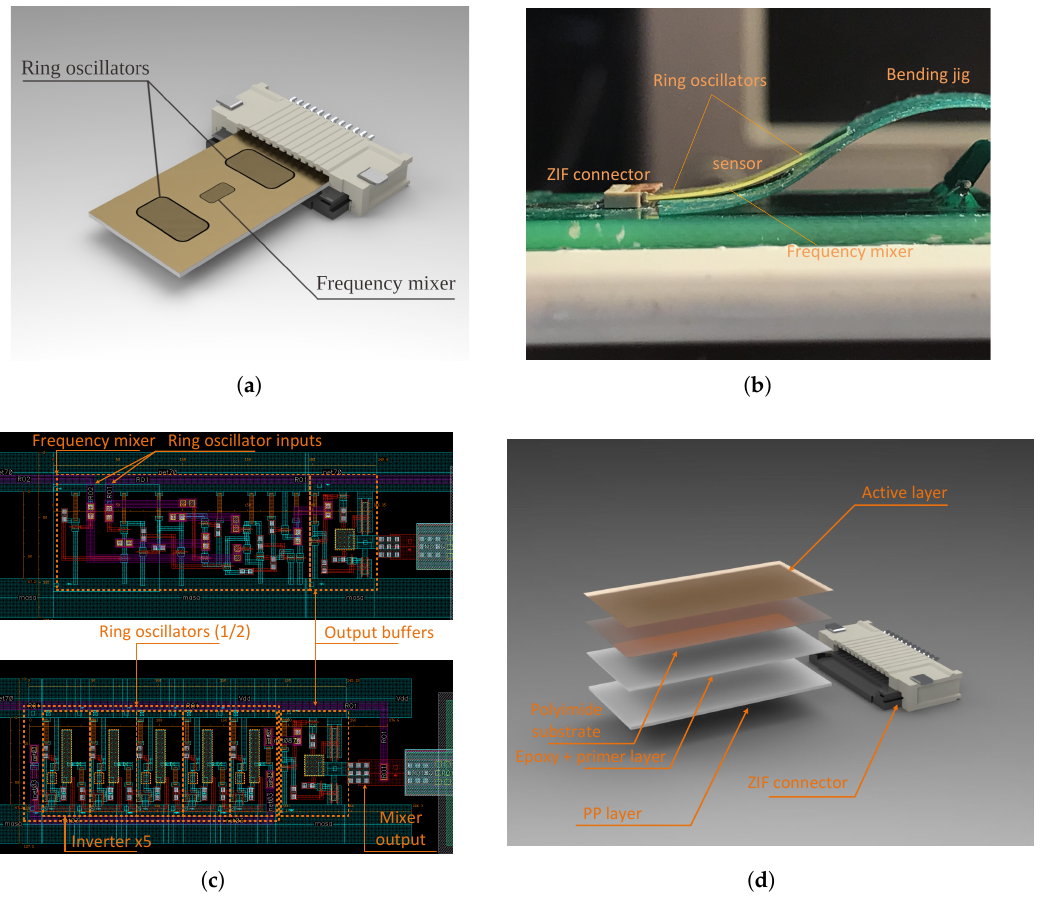
Figure 13. Mechanical assembly mode —SolidWorks bottom view ( a ), its physical implementation (side view) during tension measurements ( b ), internal sensor structure layouts ( c ), and ( d ) the complete sensor layer stack (bottom